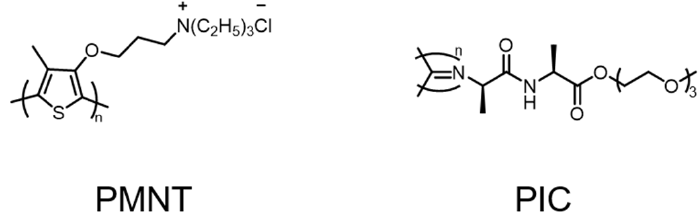
Figure 4. Chemical structures of PMNT and PIC.